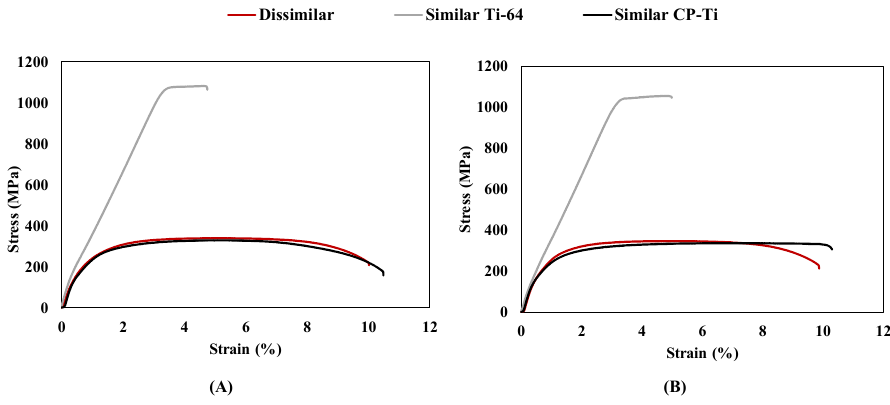
Figure 6. Stress–strain curves for joints welded by ( A ) 3 kW and ( B ) 4 kW laser power. Table 3. Average mechanical properties for all the welded joints.